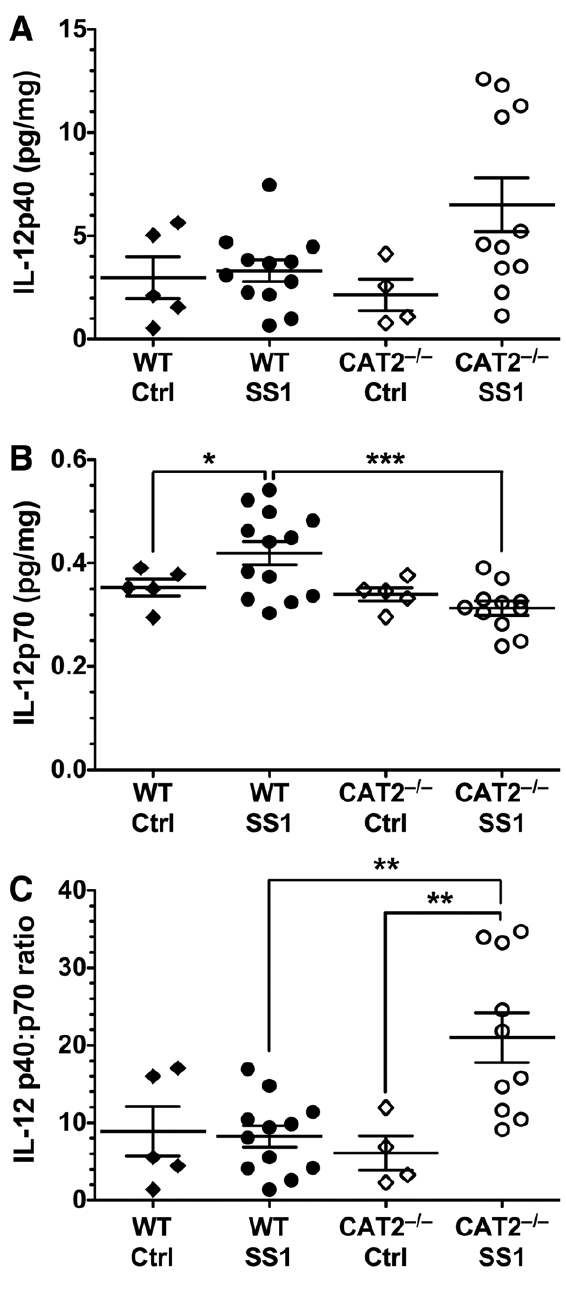
Figure 4. Expression of IL-12, a Th1-response regulator, in response to H. pylori infection is altered in CAT2 2 / 2 mice. Protein lysates were obtained from gastric tissues from mice infected for 4 months with H. pylori SS1 or uninfected controls. Levels of IL-12 cytokines (normalized to total protein levels) were quantified by Luminex. (A) IL-12p40 levels. (B) IL-12p70 levels. (C) Ratios of IL-12p40 to IL-12p70. Each point represents a single mouse ( n =4–12 per group). *, p , 0.05; **, p , 0.01; ***, p , 0.001 for comparisons